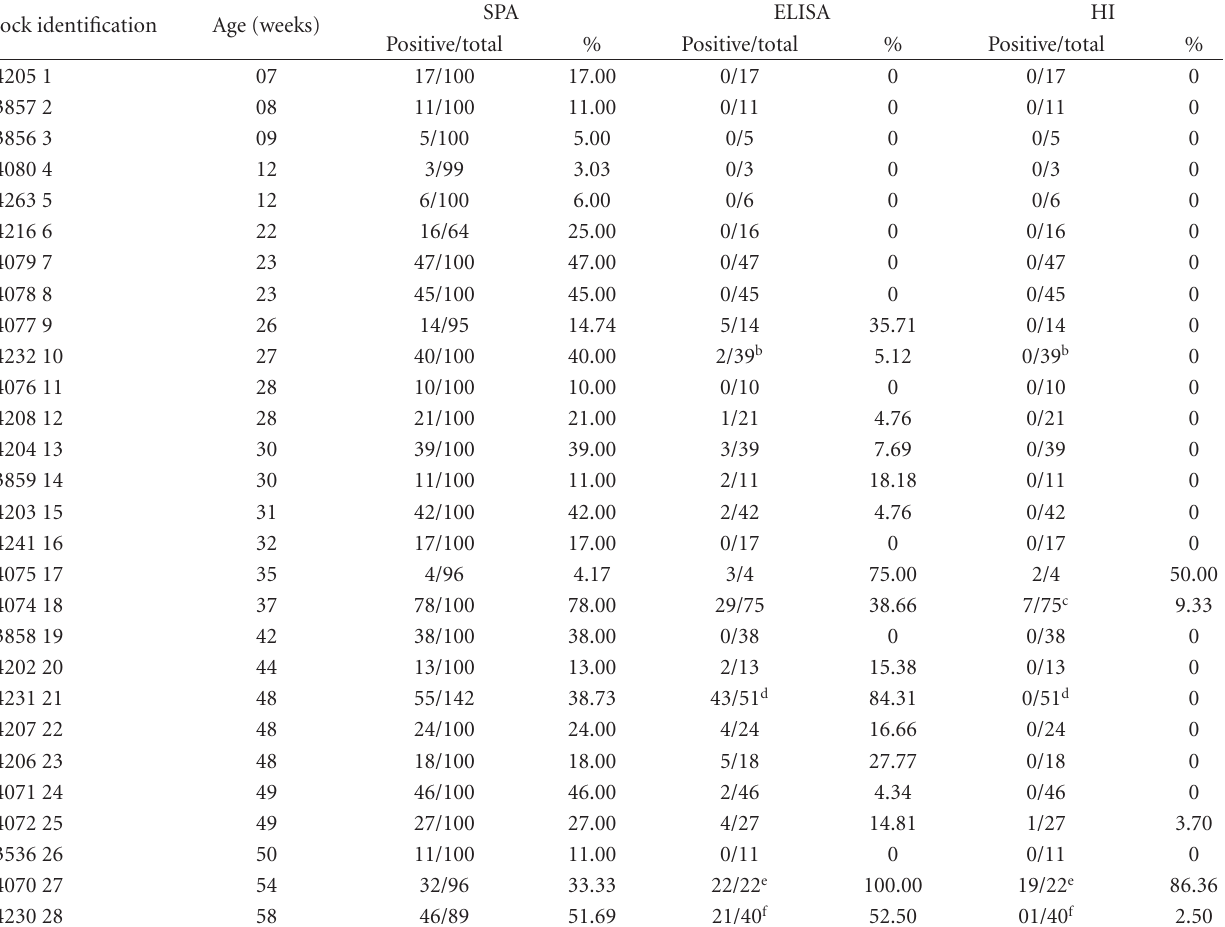
Table 2: Comparison of SPA, HI, ELISA for Mycoplasma synoviae diagnosis in commercial poultry breeders by flock and age a . Flock